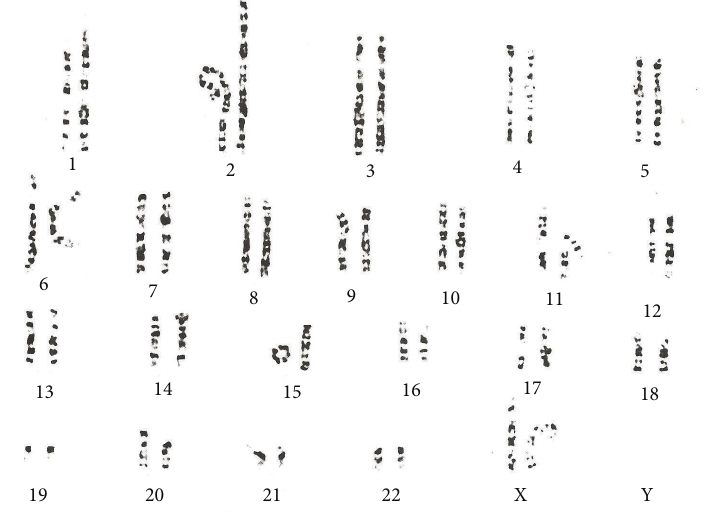
Figure 1: The karyotype of 46,XX, r(15)